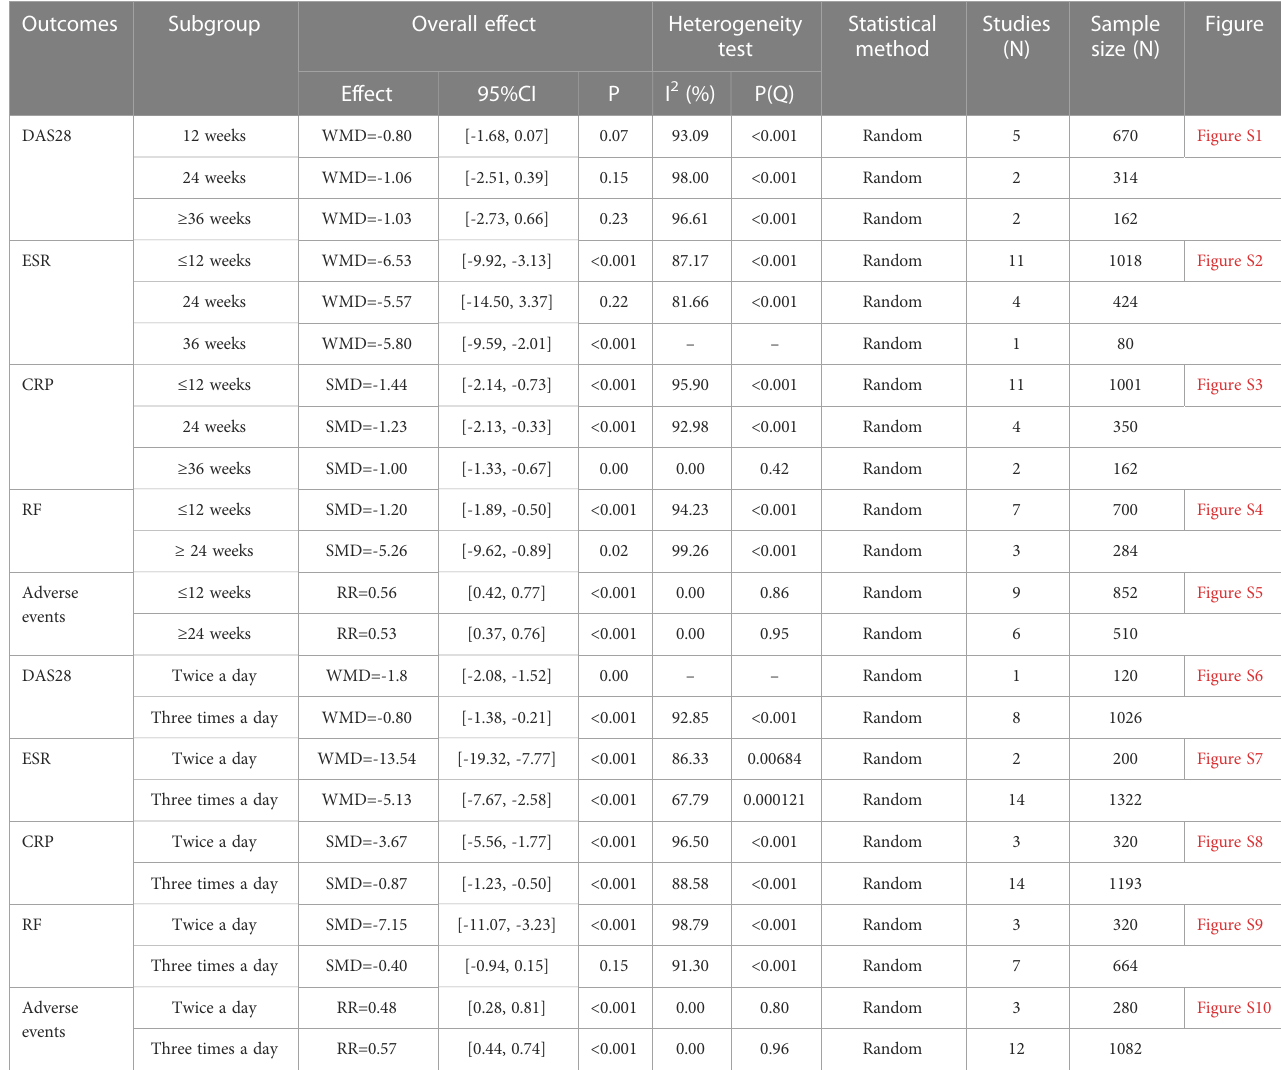
TABLE 2 Subgroup analysis results of Total glucosides of paeony.